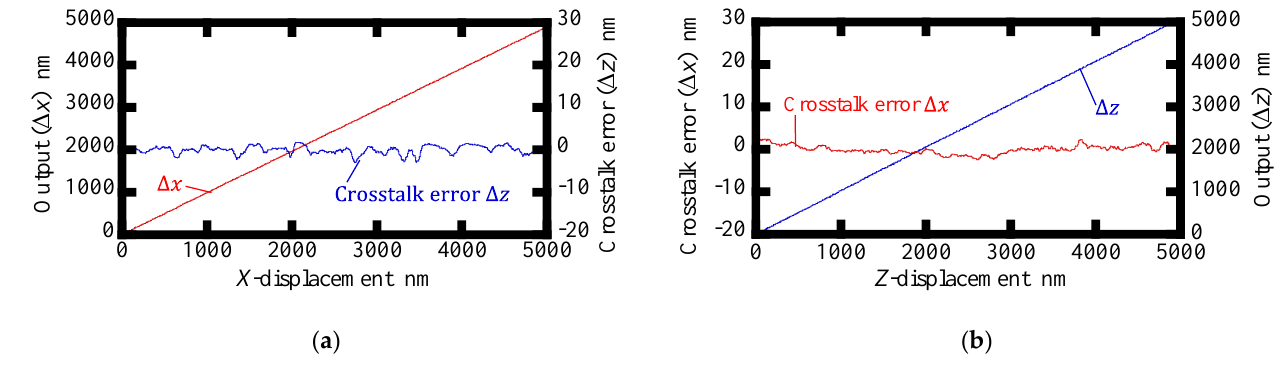
Figure 9. Crosstalk errors observed in the proposed surface encoder: ( a ) Readouts of Δ x and Δ z when giving the X -displacement; ( b ) Readouts of Δ x and Δ z when giving the Z -displacement. To further verify the feasibility of the proposed surface encoder, interpolation errors in each axis were investigated. In this experiment, the scale grating was made to travel along the X - or Z -axis at a fixed speed of 500 nm/s by using the PZT stage. The interpolation errors when measuring the X - and Z -directional scale displacements are shown in Figure 10a and 10b, respectively. The interpolation errors were found to be approximately ±8 nm and ±14 nm for the measurement of the X - and Z -displacements, respectively. Imperfections in the optical components, misalignment between axes of components, and nonlinearities in signal processing systems could result in interpolation errors [39,40].